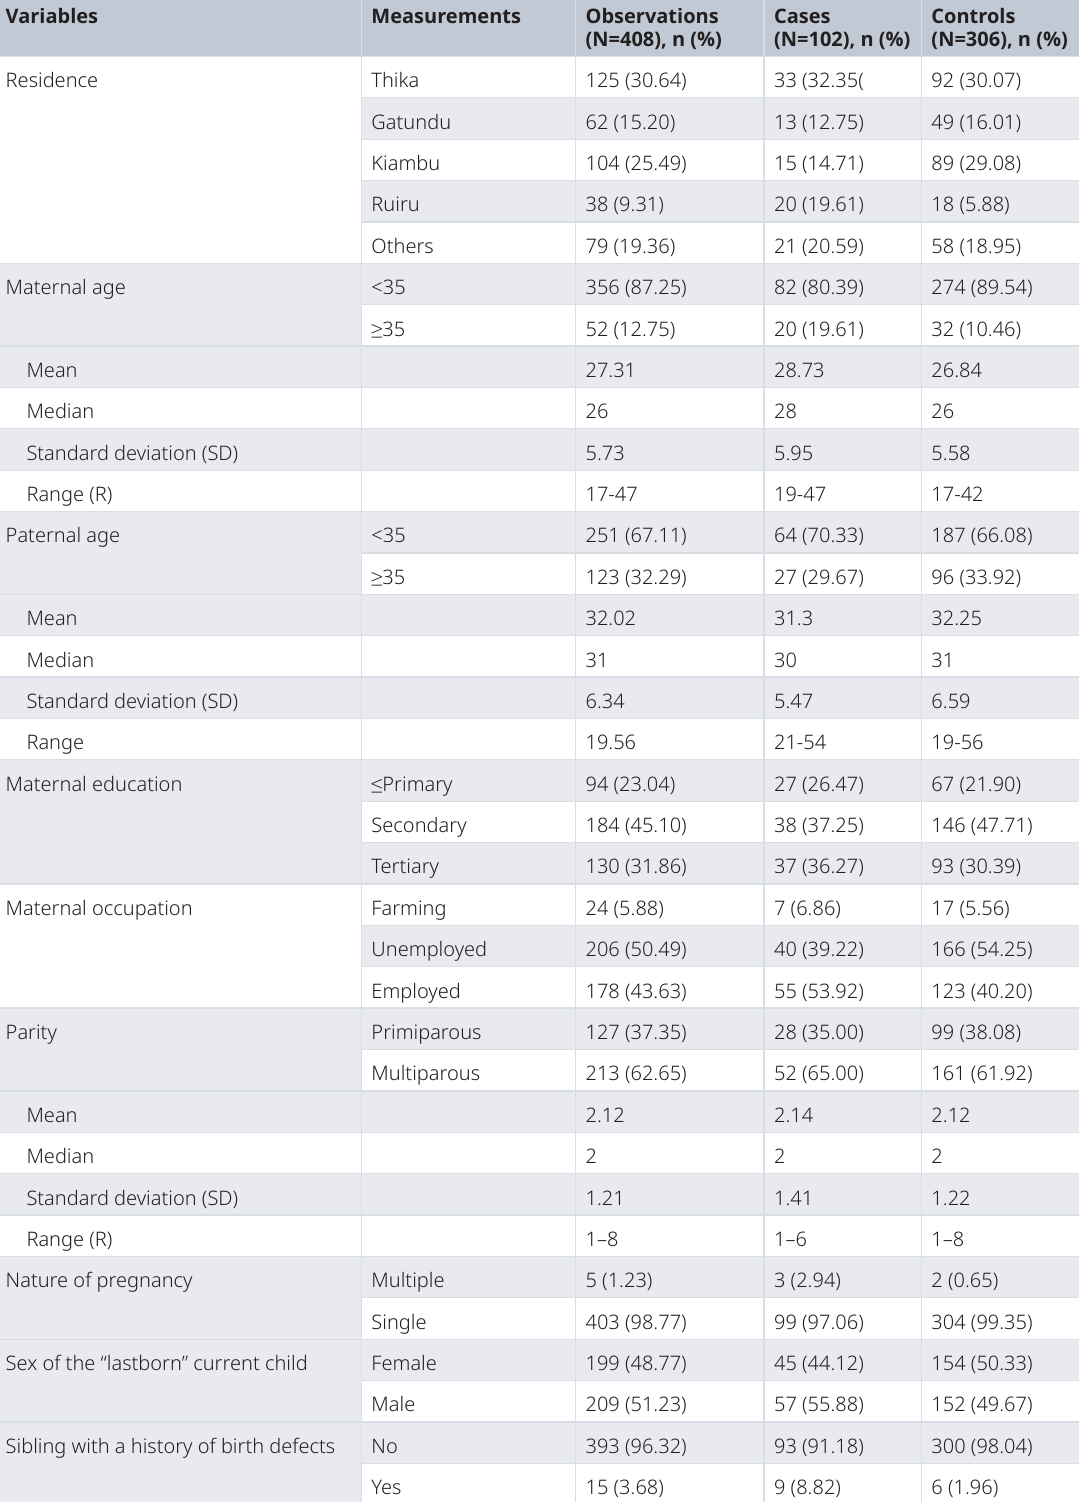
Table 2. Descriptive statistics of the study respondents